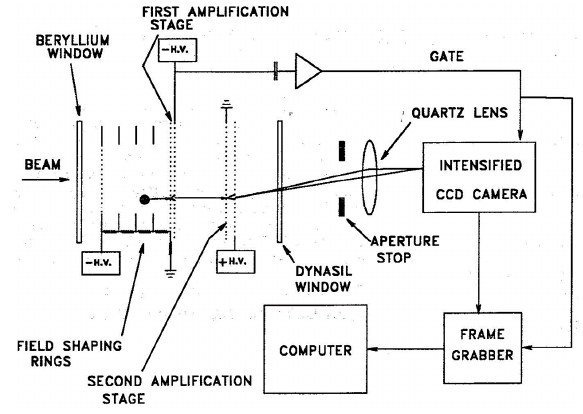
Figure 8. Schematic of the optical imaging chamber.